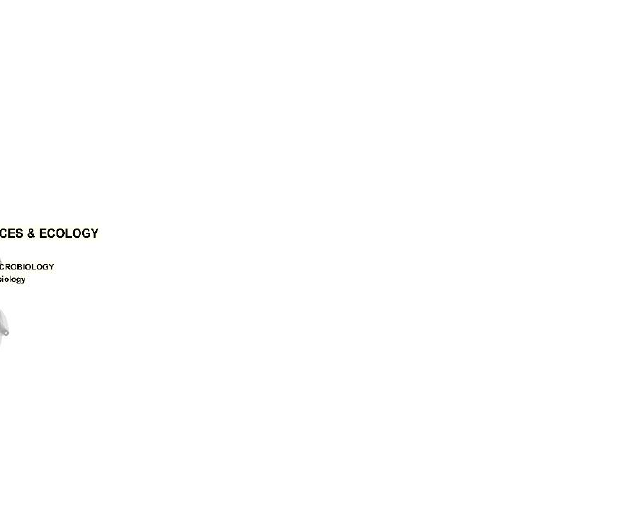
Figure 11. The analysis was performed on the categories in which the documents on industrial effluent and sludge toxicity from 1951 to 2018 were divided into. This analysis has been executed via the utilization of CiteSpace software. Table 7. The top 10 categories in which the documents on the industrial effluent and sludge toxicity analysis from 1951 to 2018 were divided into. The results have been achieved by the CiteSpace software. The first two categories with the highest corresponding frequencies have not received a value regarding their burst. These two categories were focused on this field more frequently and not specifically in a short duration of time, which is defined as a burst as the scientometric criterion.